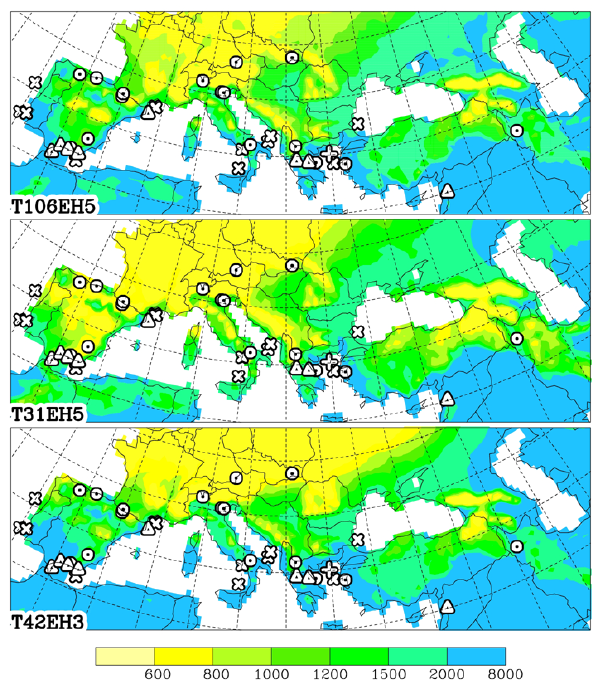
Fig. 9. Growing degree days above 5 ◦ C. Contours at 600, 800, 1000, 1200, 1500, 2000, 8000. Sites with observed tree growth during the LGM are indicated by markers as in Fig.